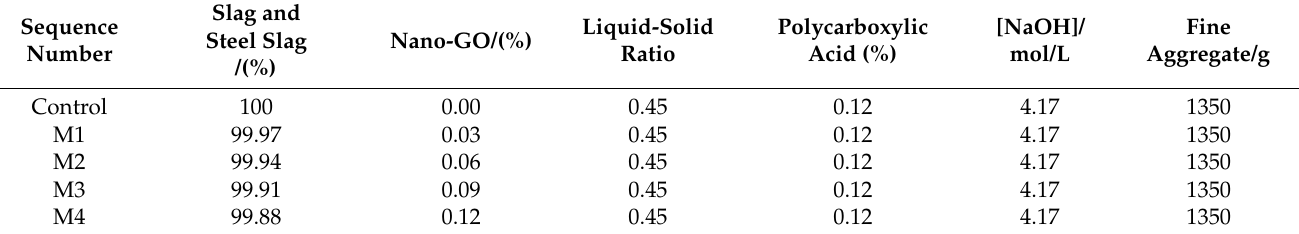
Figure 1. Nano-graphene oxide ( a ) Particle size ( b ) SEM picture. Table 2. The mixing ratio of